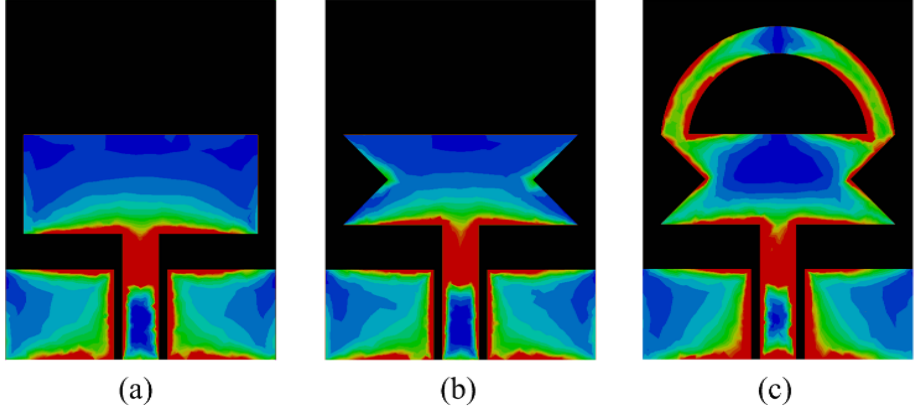
Figure 4. Surface current distribution at 3.5 GHz ( a ) step-1 ( b ) step-2 ( c ) step-3